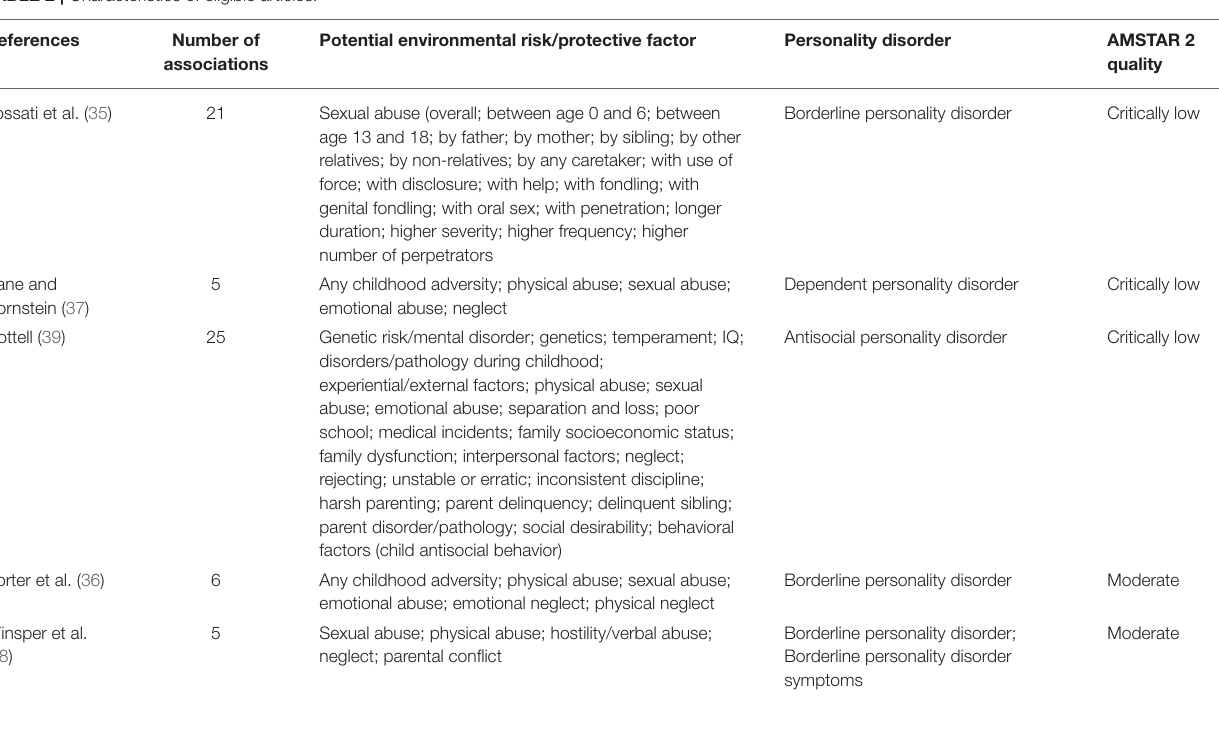
TABLE 2 | Characteristics of eligible